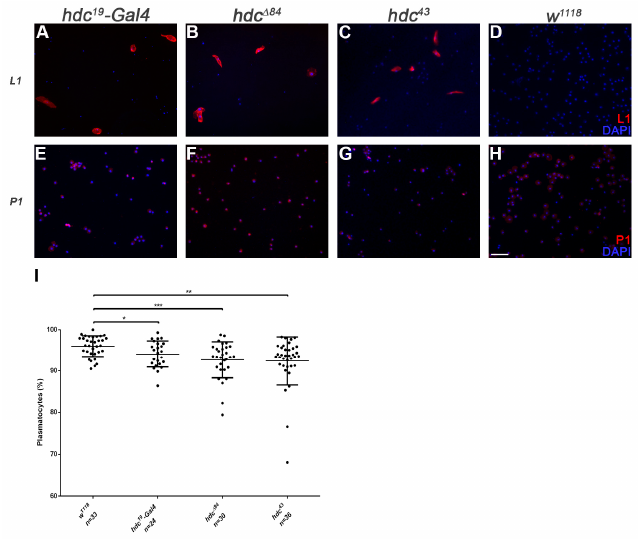
Figure 2. Circulating hemocytes of the hdc mutant larvae. ( A – D ) Lamellocytes were present in the circulation of hdc 19 -Gal4 (2.61% (n = 42)) ( A ), hdc ∆ 84 (2.15% (n = 24)) ( B ) and hdc 43 (6.07% (n = 52)) ( C ) homozygous mutant larvae. Lamellocytes were rarely observed in control w 1118 larvae (0.07% (n = 24)) ( D ). Lamellocytes were stained with L1 antibody (red); ( E – H ) Reduced plasmatocyte ratio was observed in hdc 19 -Gal4 ( E ), hdc ∆ 84 ( F ), and hdc 43 ( G ) homozygous mutant larvae compared to control w 1118 ( H ). Plasmatocytes were stained with P1 antibody (red). Nuclei were stained with DAPI (blue). Hemocytes were visualized on a Zeiss Axioskope 2MOT epifluorescent microscope, original magnification × 10 and processed with ImageJ and Adobe Photoshop CS2 softwares. Scale bar: 20 µ m. ( I ) Quantification of plasmatocytes in the hdc mutant larvae. Error bars represent the standard deviation of the mean. ***: p < 0.001; **: p < 0.01; *: p < 0.05. Significance was determined by unpaired Student’s t-test.